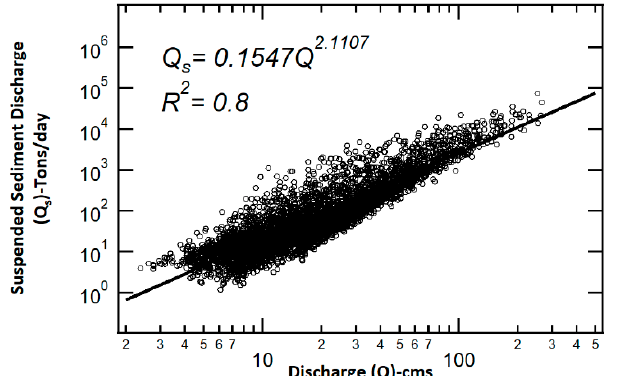
Figure 3. Suspended sediment rating curve created from data from 1950 to 2002 at the Independence stream gage.